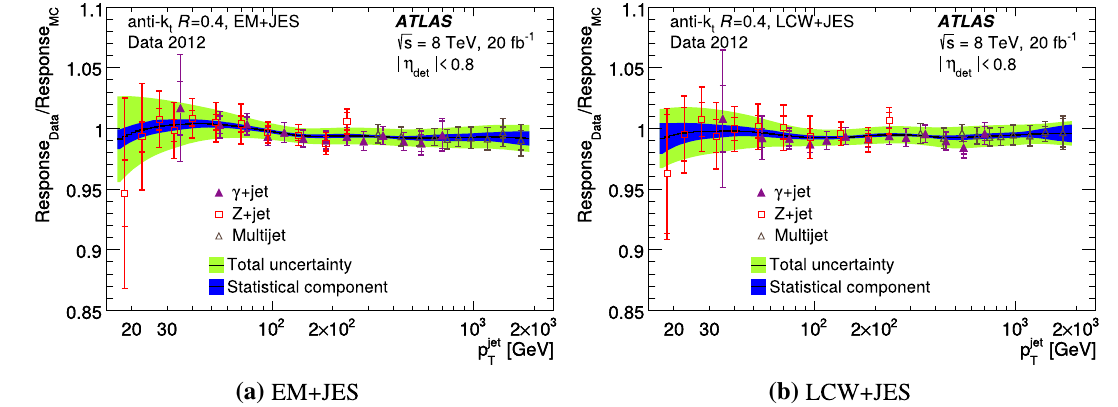
Fig. 38 Ratio of response measured in data to response measured in MC samples for Z +jet (empty squares), γ +jet (filled triangles) and multijet balance (empty triangles) in situ analyses. The method giv- ing the smallest overall uncertainty is used, corresponding to the DB approach for Z +jet and the MPF approach for γ +jet. Each measure-